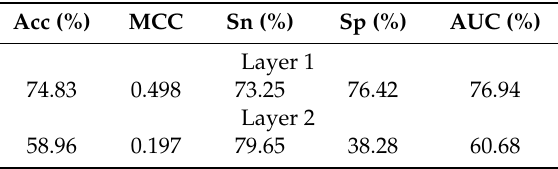
Table 6. Cross-validation results.